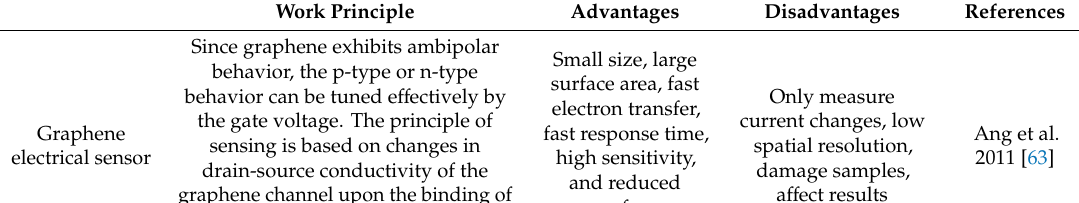
Table 1. The difference between a graphene-based electrical sensor and a graphene-based optical sensor.